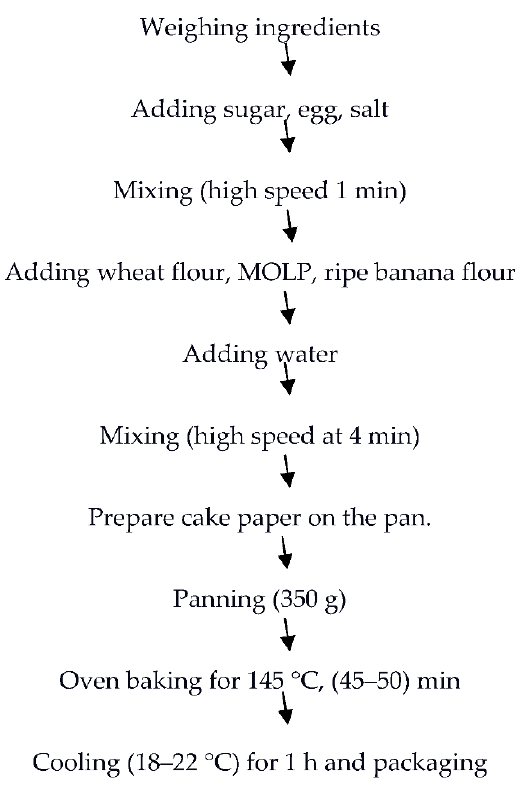
Figure 1. Flow chart of the production procedure of cake.